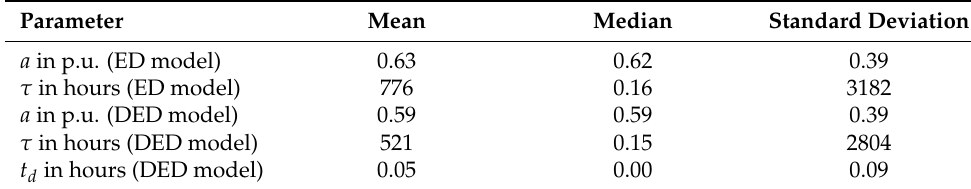
Table 1. Distribution of fitted model parameters. Parameter